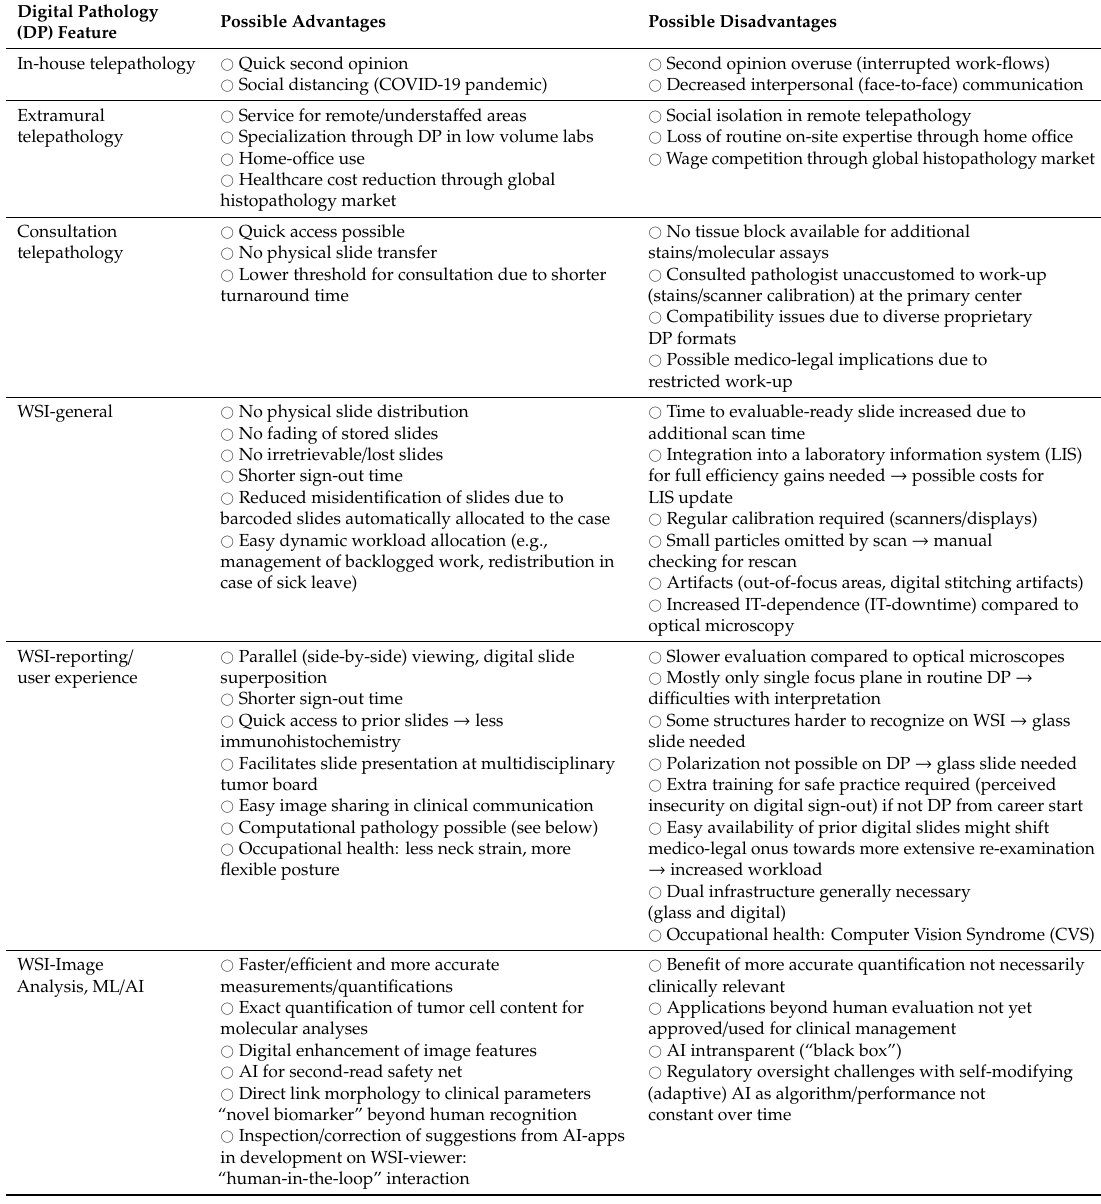
Table 1. Advantages and disadvantages in digital